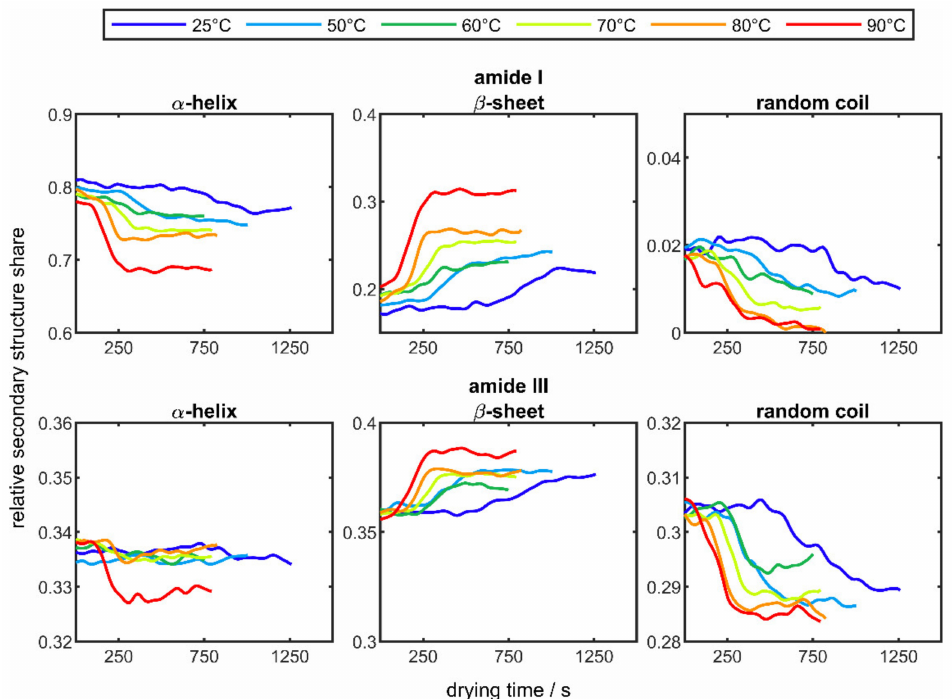
Figure 9. Averaged changes over time of the secondary structure elements α -helix, β -sheet, and random coil of lysozyme in the amide I band ( top row ) and amide III band ( bottom row ) at different drying temperatures between 25 ◦ C (blue line) and 90 ◦ C (red